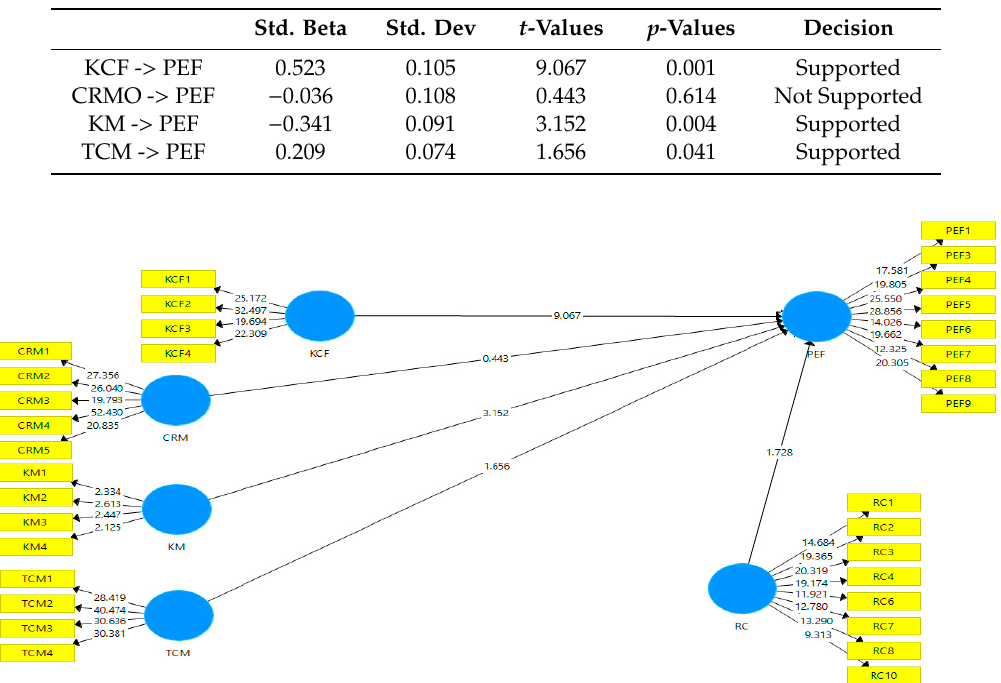
Table 5. The structural model (Direct).